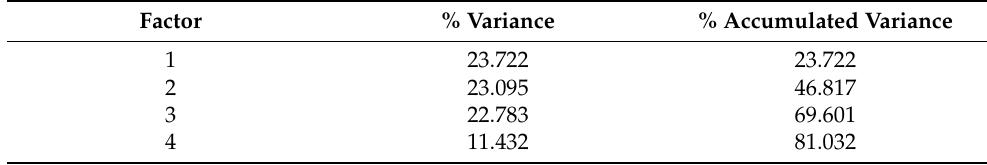
Table 4. Total of the explained